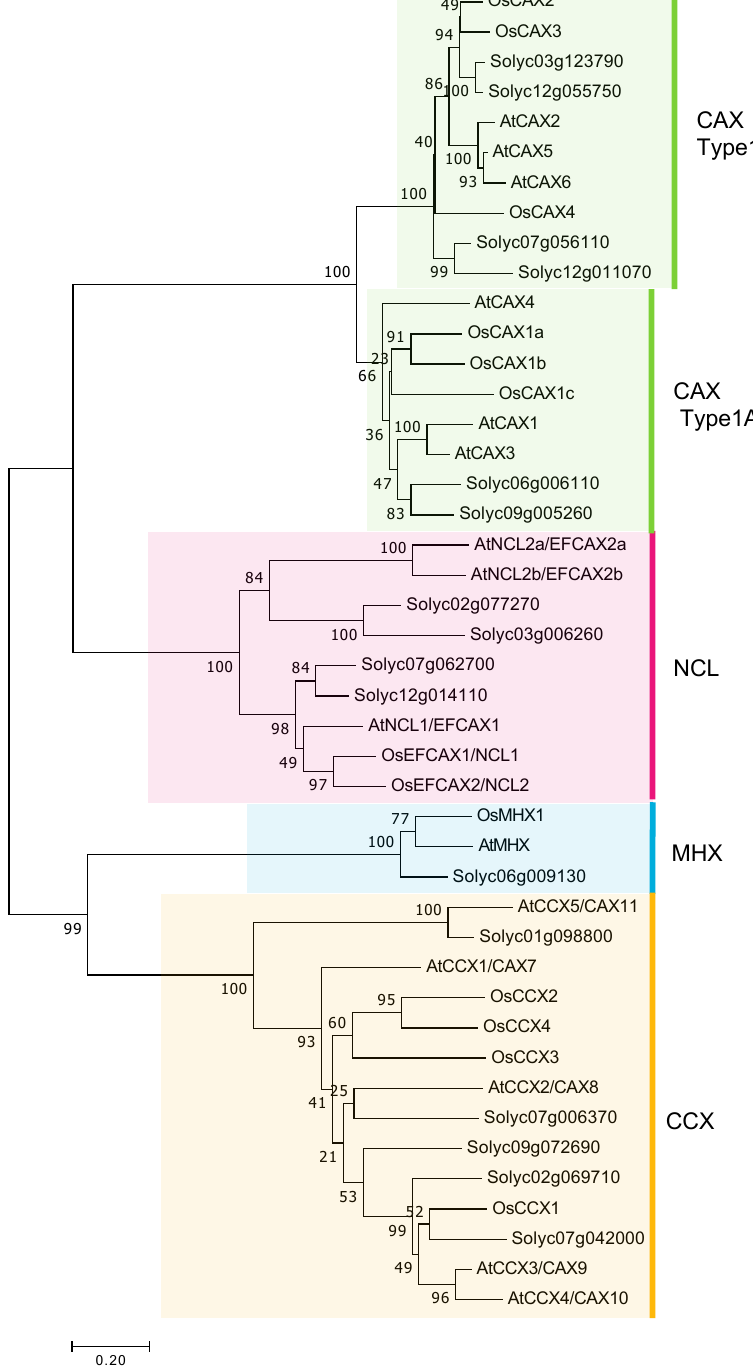
Figure 1. Phylogenetic tree based on amino acid sequences in the Ca 2 + / cation antiporter (CaCA) superfamily of the tomato, Arabidopsis , and